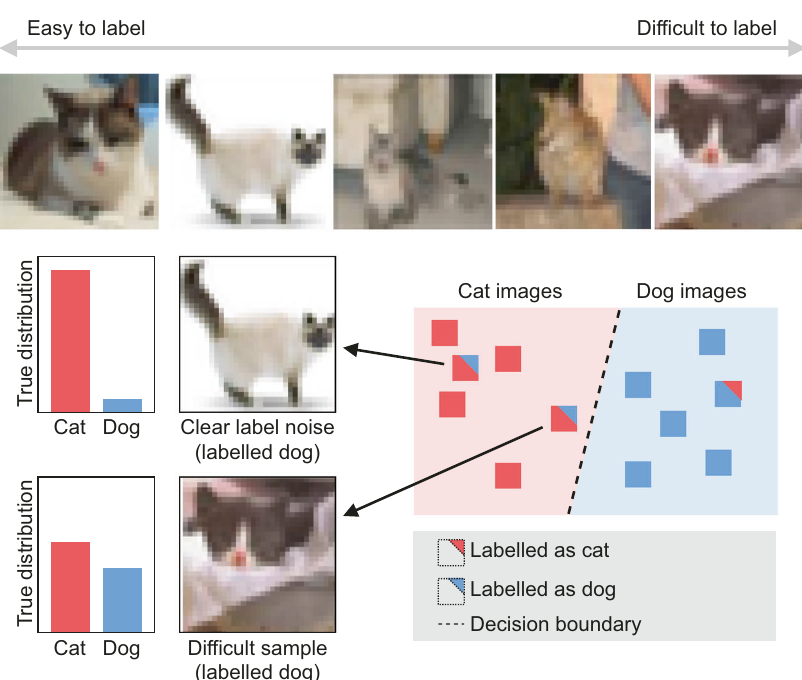
Fig. 2 Image labelling can become dif fi cult due to ambiguity in input space 26 . Top row shows the spectrum of ambiguity for cat images sampled from CIFAR10H dataset. The 2D plot illustrates different types of mislabelled samples: clear noise and dif fi cult cases. We expect the former to be adjacent to semantically similar samples with a different label, and the latter to be closer to the optimal decision